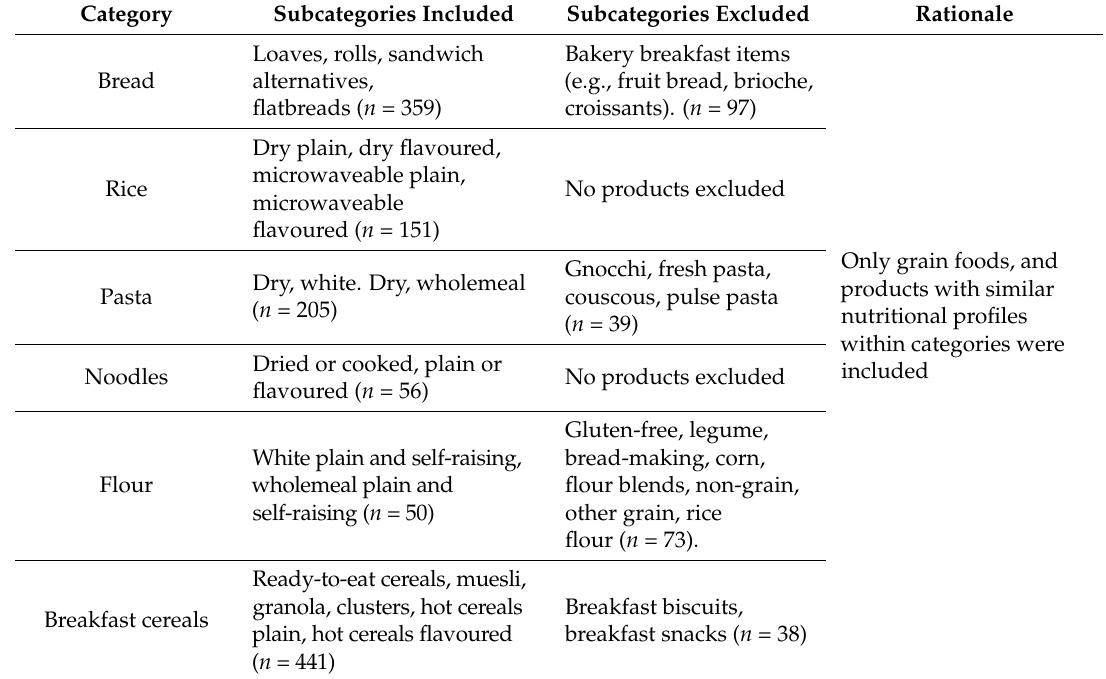
Table A1. Products included and excluded in the